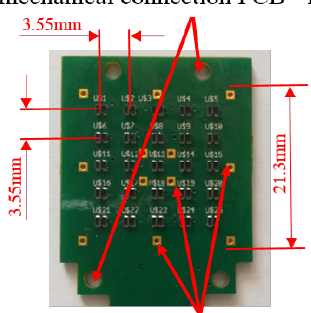
Figure 1. Details of the sensitive area on the Printed Circuit Board